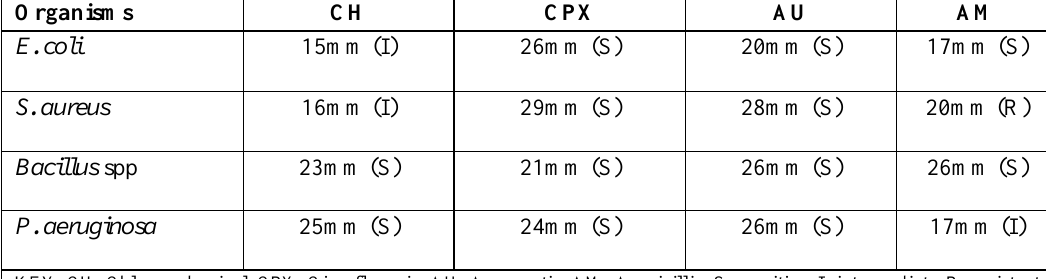
Table 4. Mean values and interpretation of inhibition zones from the sensitivity test.